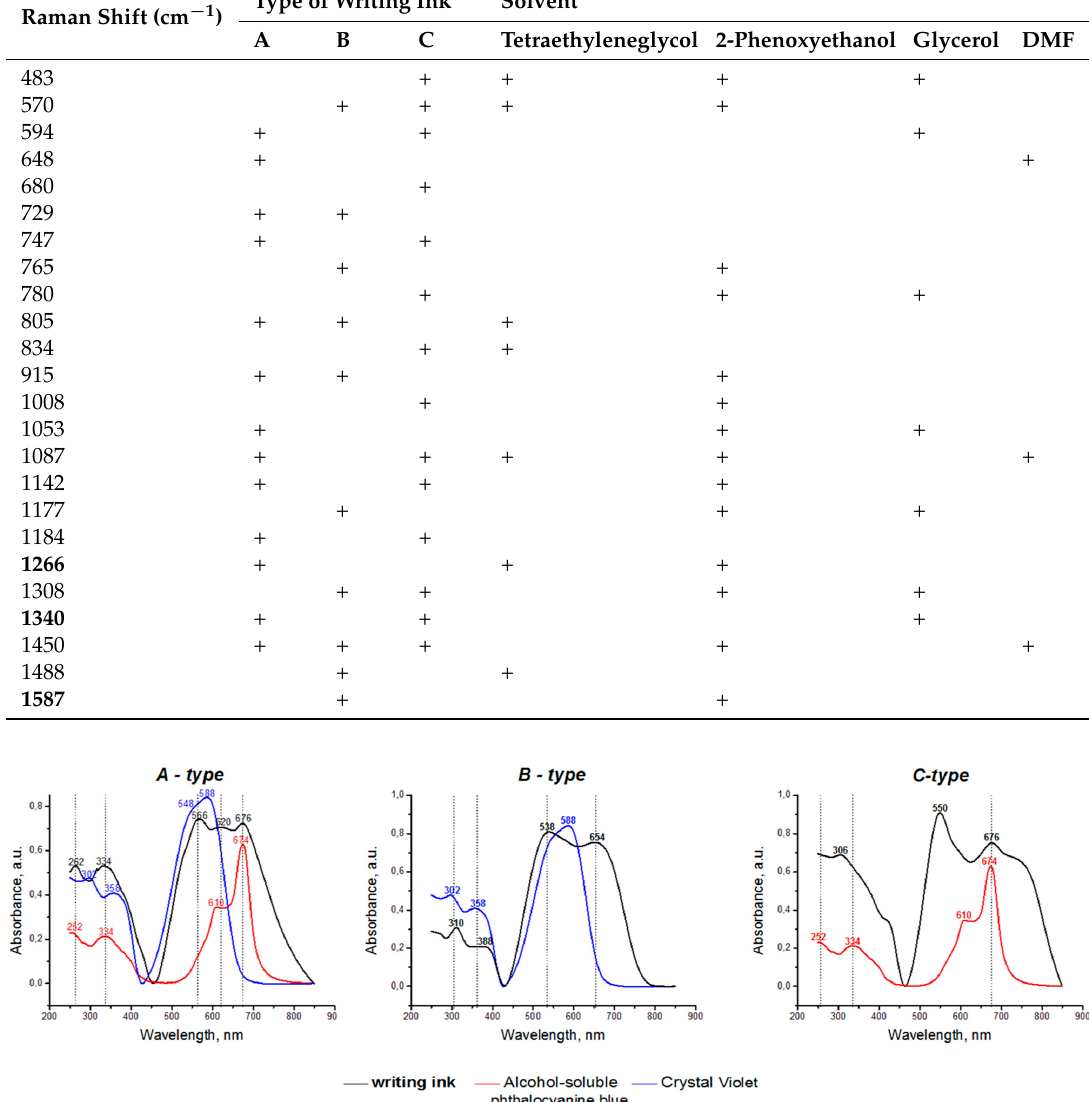
Table 5. Comparison of the Raman peaks of writing inks with respect to the Raman peaks of the corresponding pure solvents.